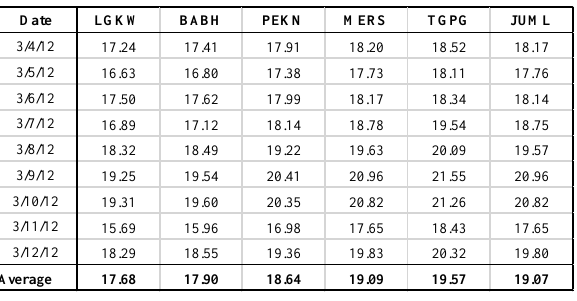
Table 5. Ionospheric delay for all MyRTKnet stations at frequency, L5= 1176.45